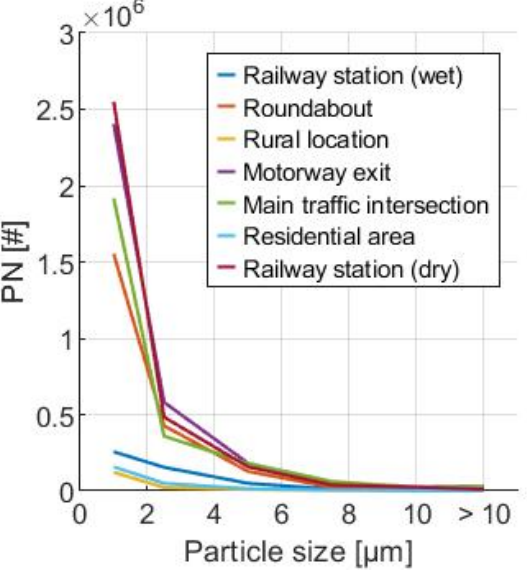
Figure 11. Microscopy of particles on the filter of the measuring station.